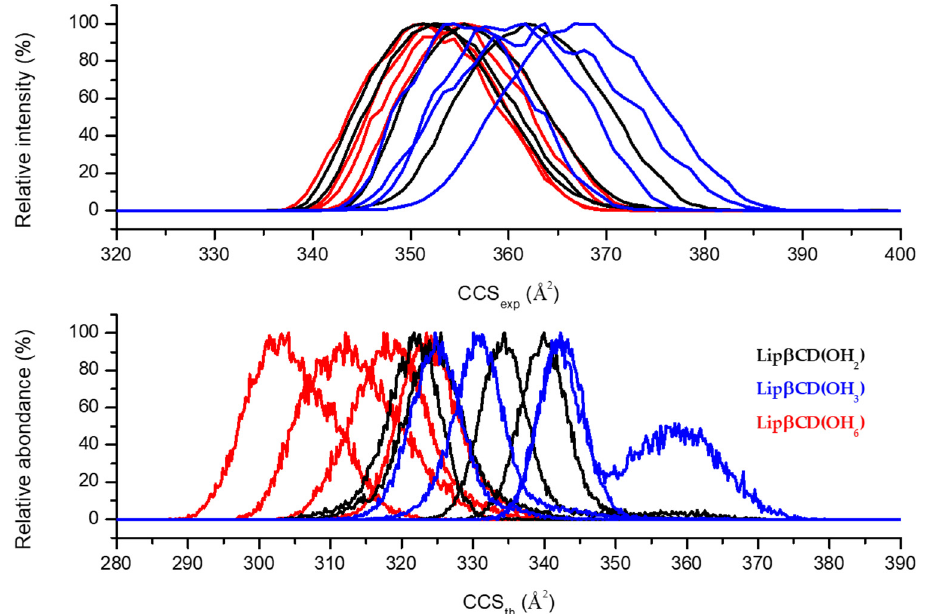
Figure 2. ( Top ): Experimental CCS (CCS exp ) values distribution obtained from IM-MS experiments. ( Bottom ): Distribution of theoretical CCS (CCS th ) values computed on an ensemble of minimal struc- tures obtained from metadynamics simulations for the 12 isomers of Lip β CD.